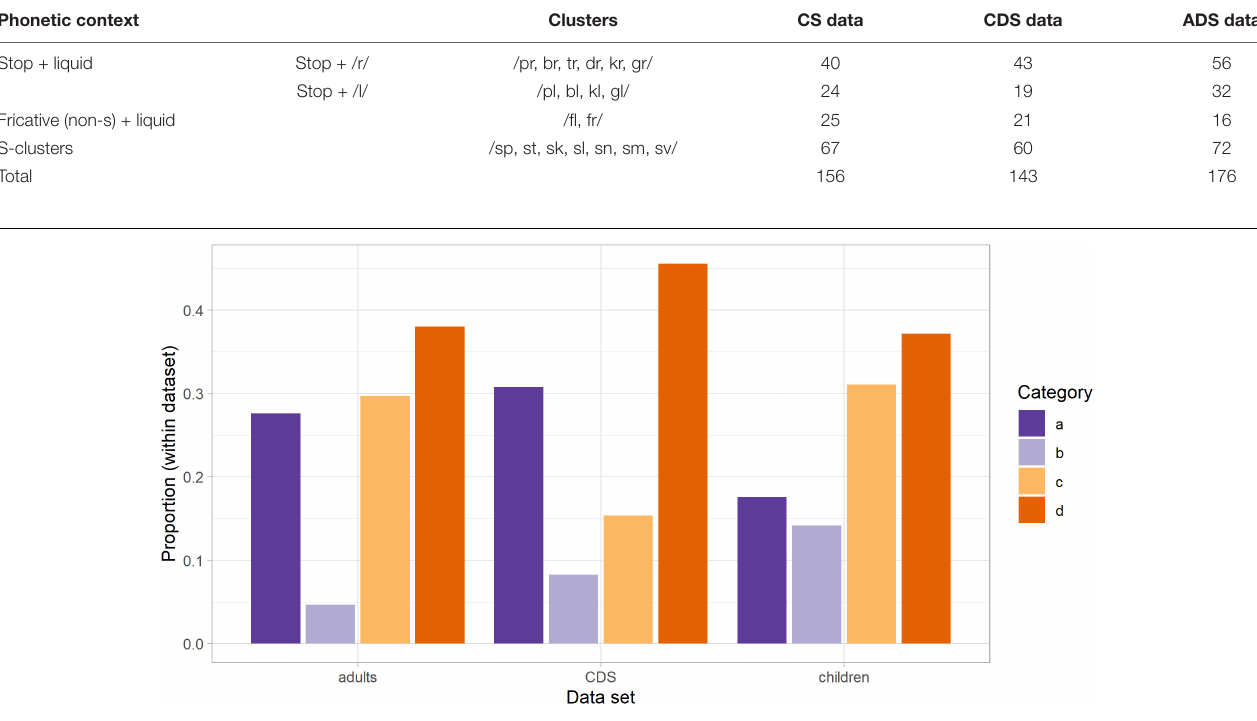
TABLE 2 | A breakdown of cluster types analysed in this paper, with incidences for each category of speech data.